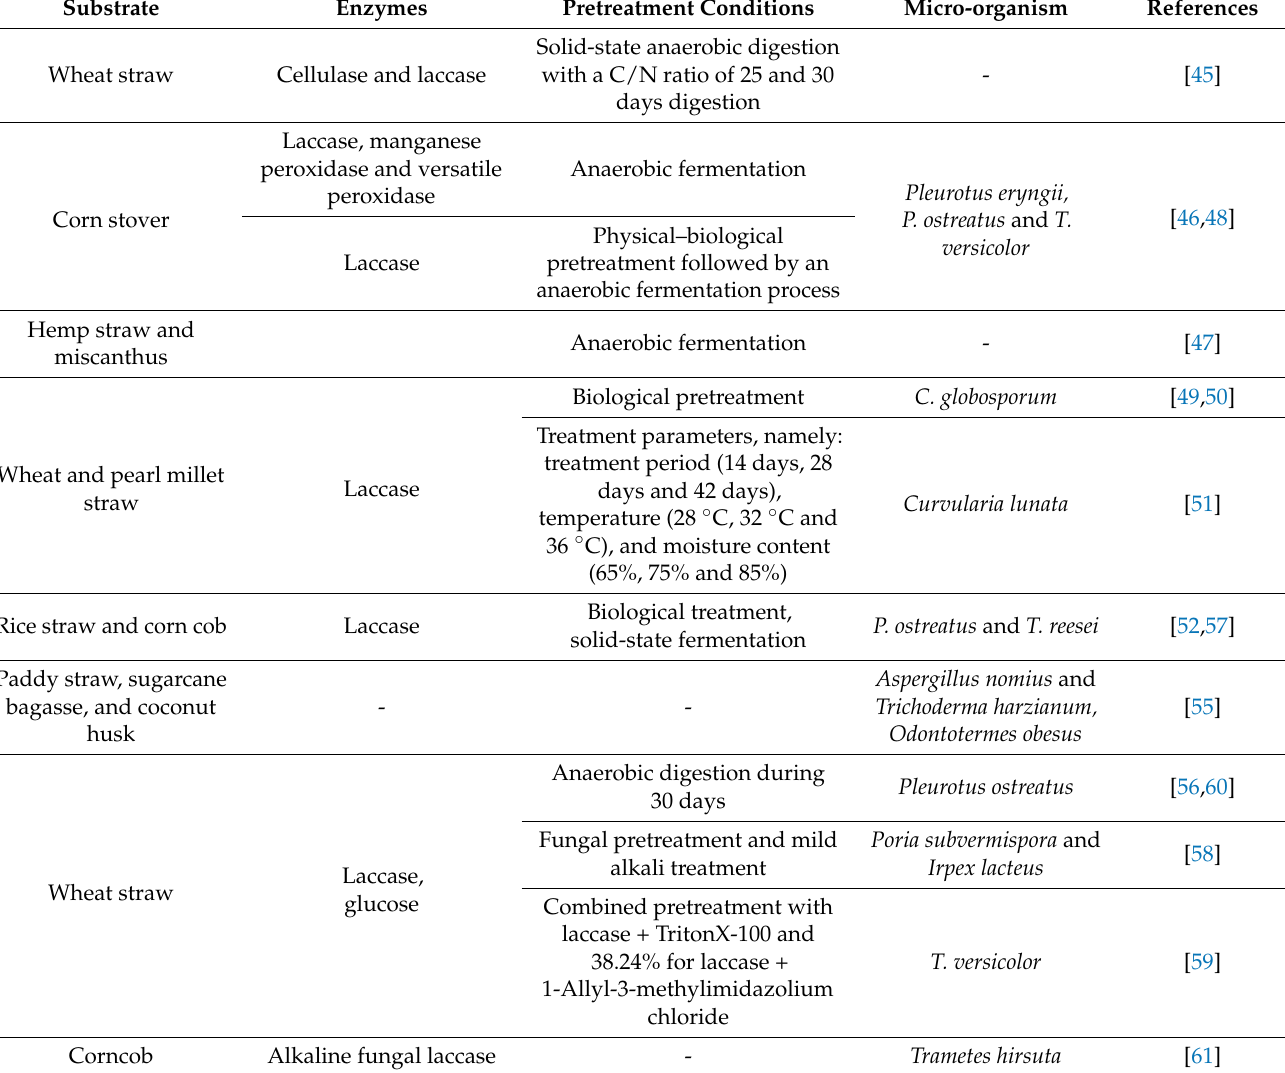
Table 1. Enzyme types used in LB pretreatment